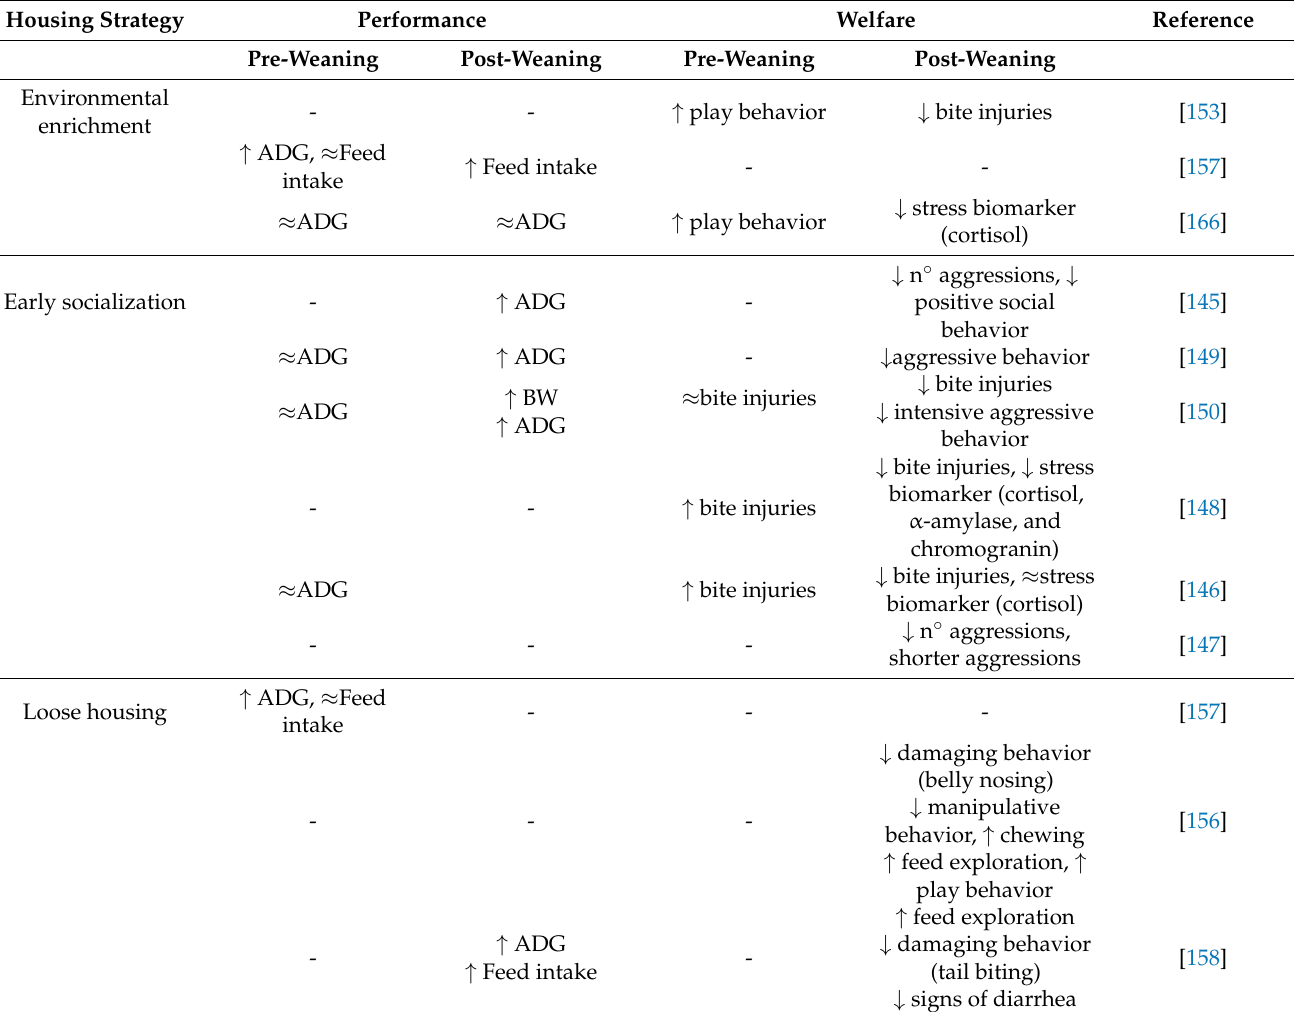
Table 1. Performance and welfare-associated effects before and after weaning of different housing interventions during lactation in